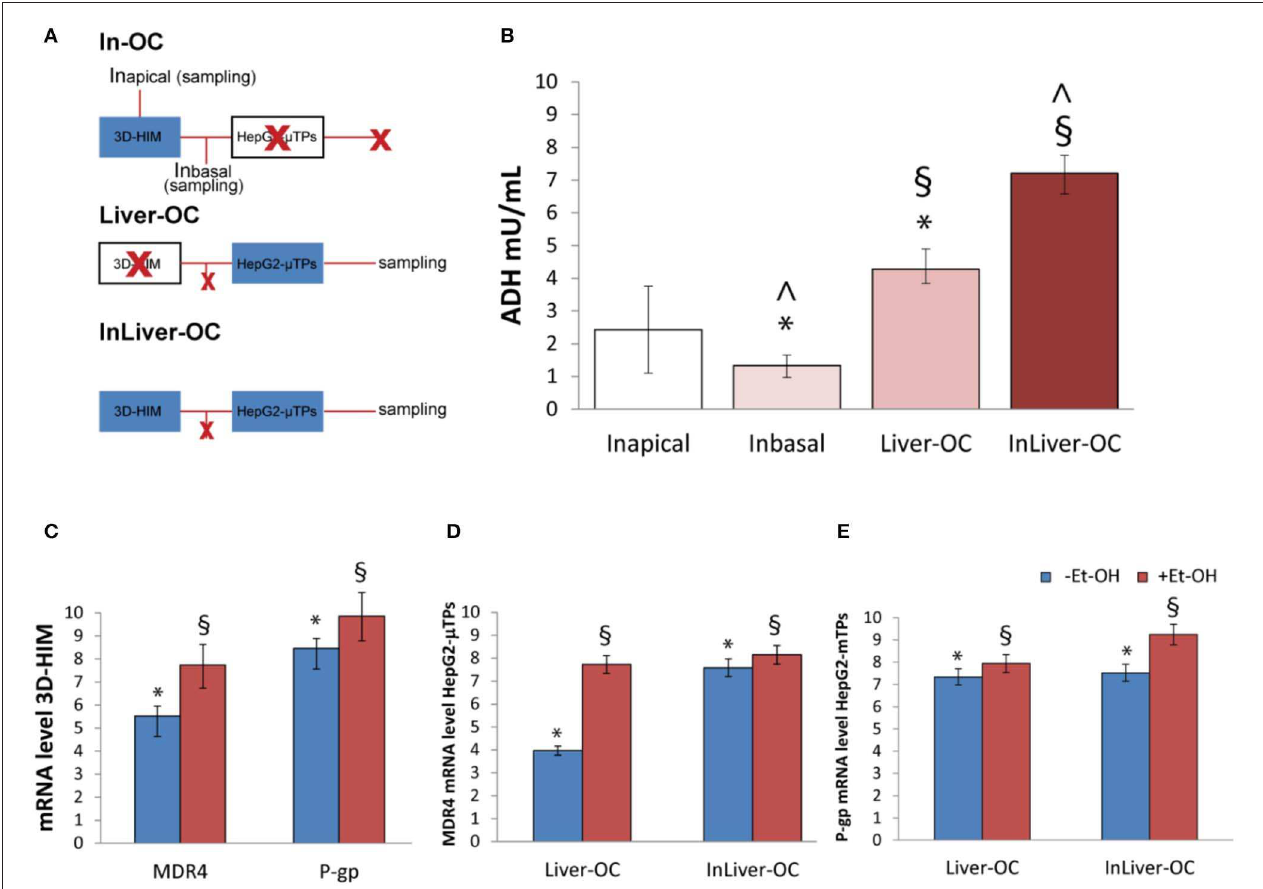
FIGURE 8 | Synergic response of 3D-HIM and HepG2- µ TPs after Et-OH administration. Overview of the experimental design: In-OC (device loaded with 3D-HIM without HepG2- µ TPs), Liver-OC (device loaded with HepG2- µ TPs without 3D-HIM) and InLiver-OC (device with both HepG2- µ TPs and 3D-HIM); In apical sampling indicates the tissue supernatants collected from the apical compartment of the Intestine c , In basal indicates the tissue supernatants collected between the Intestine c and Liver c and sampling indicates the tissue supernatants collected downstream to the Liver c (A) ; quantification analysis of ADH activity in the Intestine apical (In apical ), in the sampling channel (In basal ), Liver-OC, and Liver-OC; “ ∧ ” indicates that the group samples Inbasal and InLiver-OC are considered to be statistically significant ( p < 0.001) (B) ; quantification analysis of P-gp and MDR4 genes expression on untreated (–Et-OH) and Et-OH-treated ( + Et-OH) 3D-HIM (* p < 0.0001; § p < 0.05) (C) ; MDR4 (D) ; and P-gp (E) gene expression of untreated (–Et-OH) and Et-OH-treated ( + Et-OH) HepG2- µ TPs (* p < 0.001; § p < 0.05) in the two different